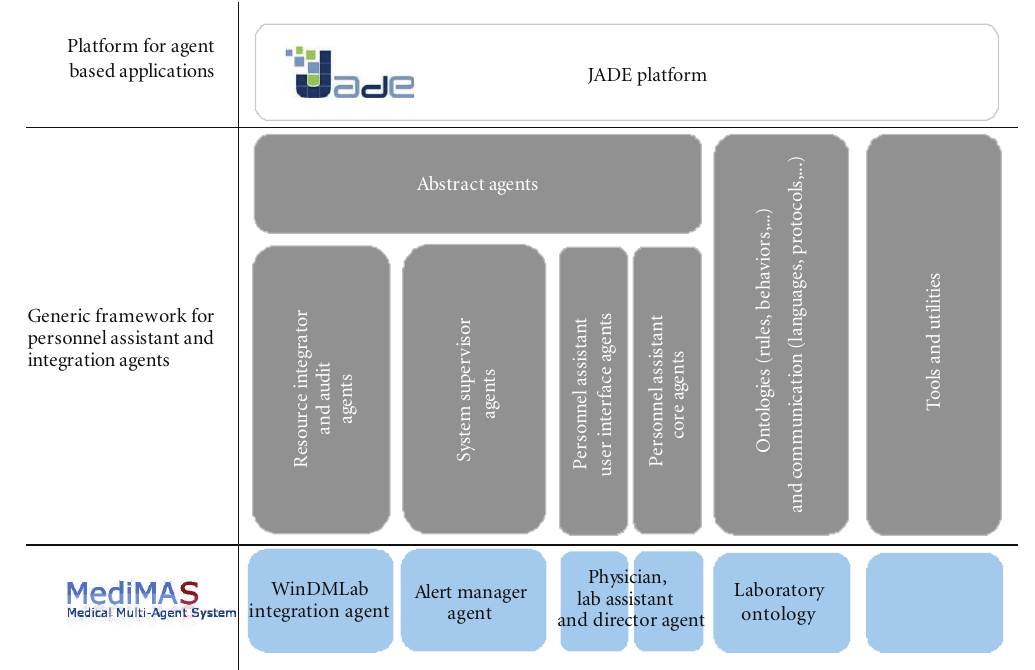
Figure 10: Overview of the software